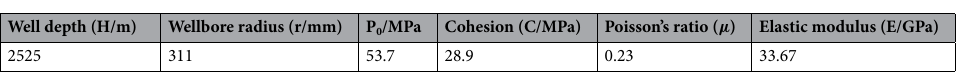
Table 4. Formation parameters.